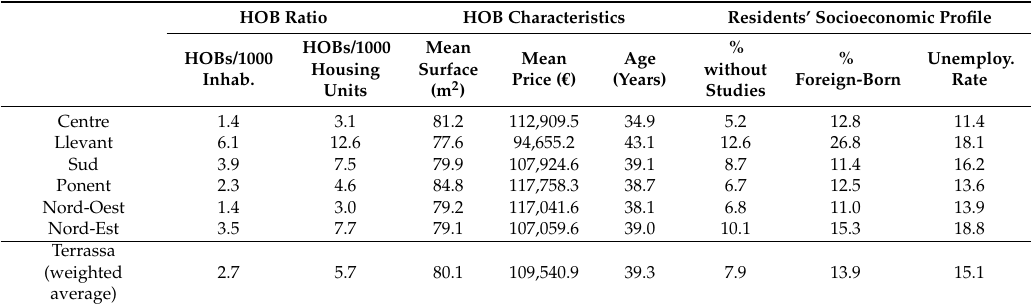
Table 4. HOB distribution by neighborhood according to their characteristics and socioeconomic profiles